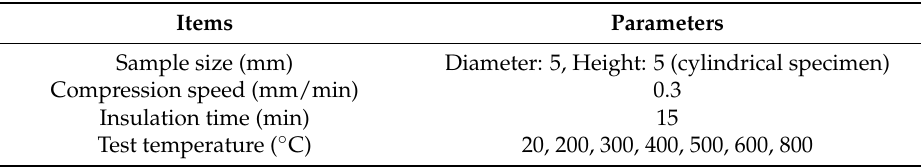
Table 2. Design of experiment for uniaxial compression experiments.